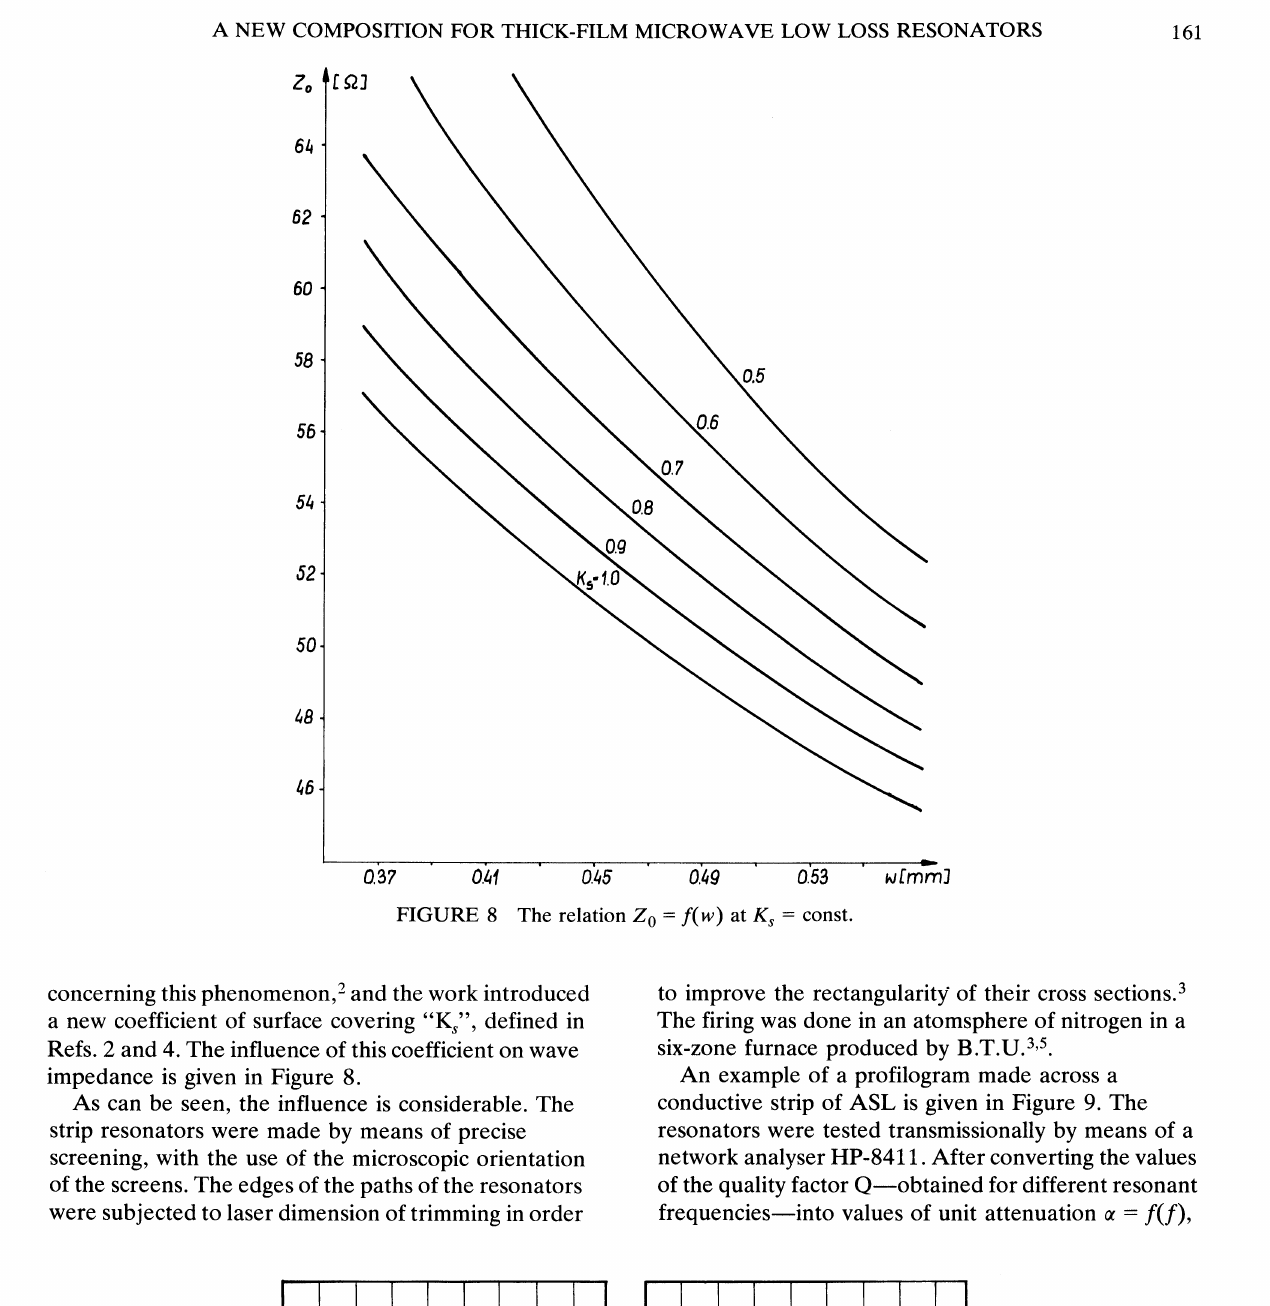
FIGURE 9 Profilogram of main ASL strip printed with DP9922/Cu. Magnification" X 50x, Y